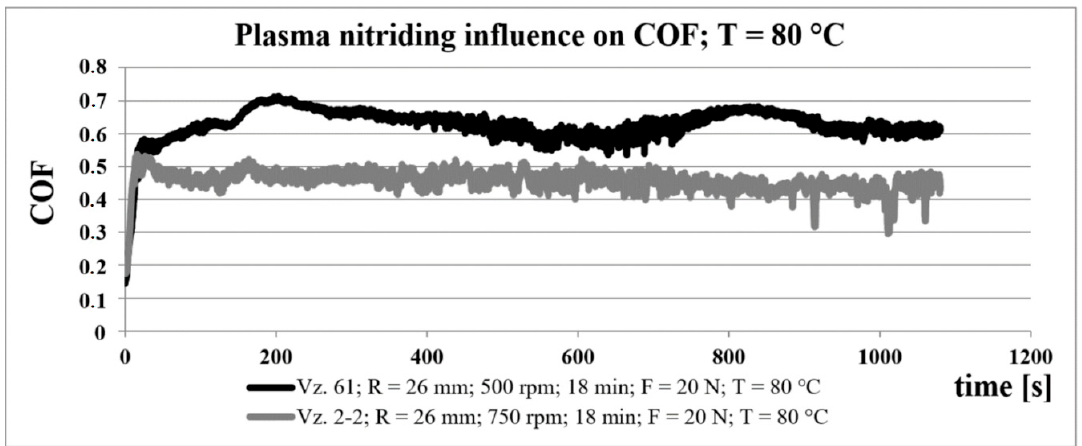
Figure 8. Comparison of COF of nitrided (vz. 2-2) and non-nitrided (vz. 61) specimens; steel equivalent 17Ni4CrMo (i.e., CSN 41 6720); measured at higher temperature. The temperature-dependence of COF can be attributed to the creation of oxides in the wear